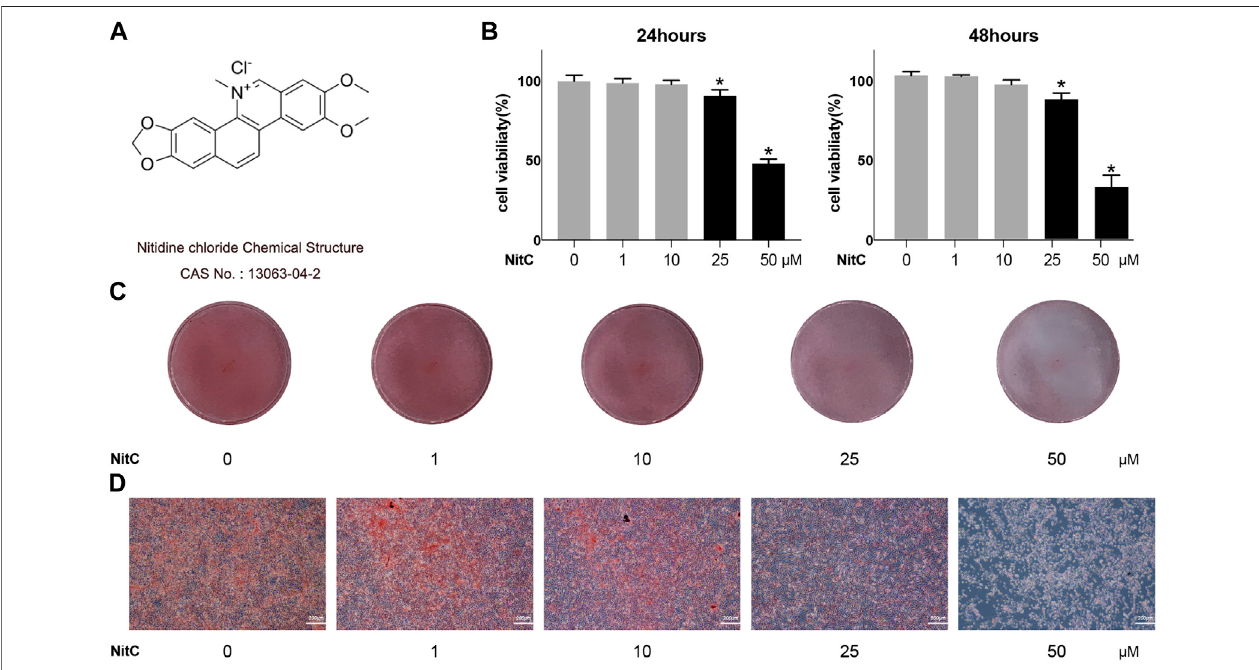
FIGURE 1 | Effect of NitC on viability and chondrocyte phenotype maintenance. (A) Nitidine Chloride (NitC) chemical structure. (B) CCK8 analysis of NitC on chondrocytesviability. (C) GrossviewofsafraninOstainedprimaryratarticularchondrocytestreatedwith0,1,10,25,or50 μ MNitCin12wellsfor24 h. (D) Microscopic images of safranin O stained primary rat chondrocytes treated with 0, 1, 10, 25, or 50 μ M NitC for 24 h. *p < 0.05 versus the control group. Scale bar = 200 μ M.